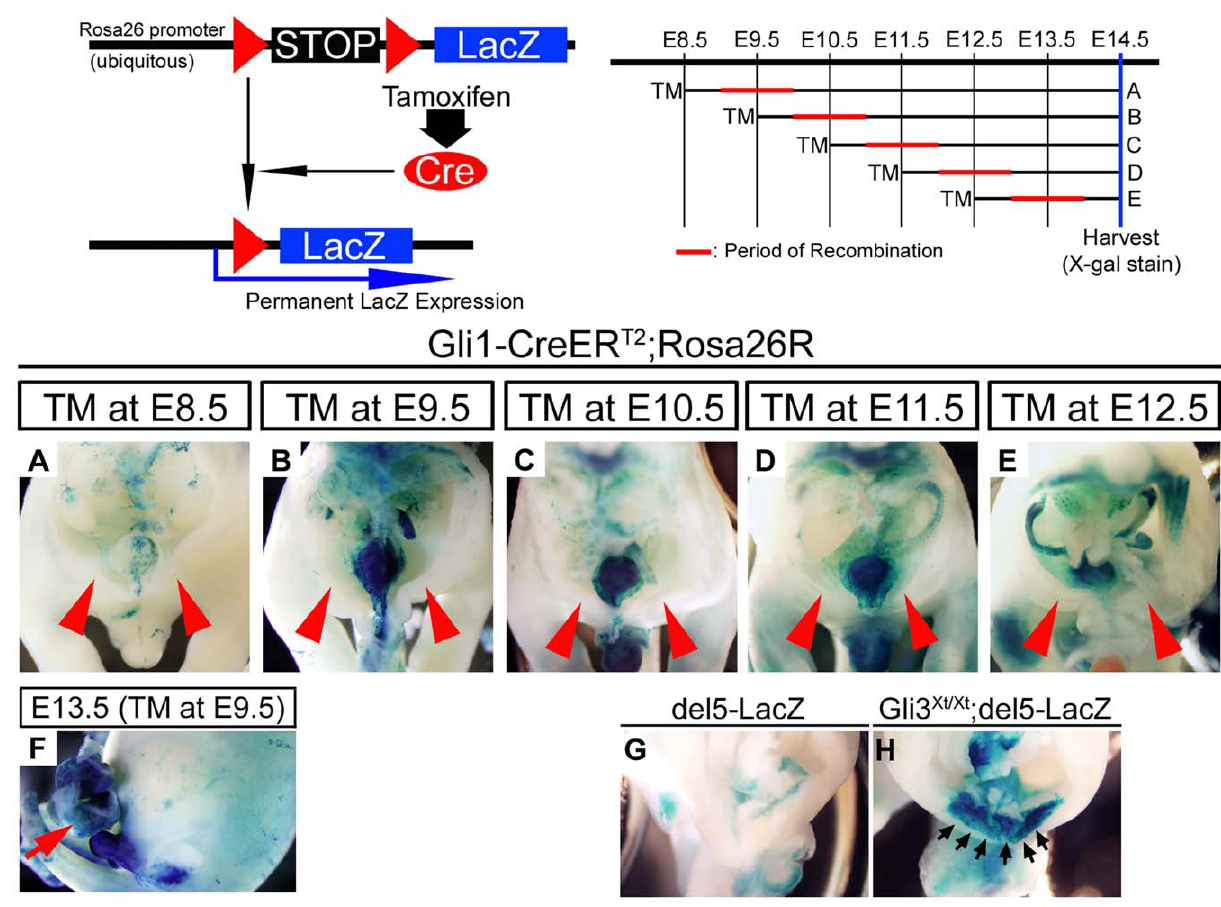
Figure 4. The analysis of Hh-responded cells in the ventral body wall region. A schematic diagram of Hh-responsive cell contribution assays. The R26R allele contains the LacZ gene and a floxed stop cassette under the Rosa26 promoter. The Gli1-CreER T2 allele contains an insertion of TM-inducible Cre recombinase into the Gli1 gene locus. By crossing the Gli1-CreER T2 ; Rosa26R and ICR mice, gene recombination in Hh-responded cells could be achieved specifically under the control of TM. The embryos were stained with X-gal and dissected horizontally at the umbilical cord level. The stages of TM administration and estimated recombination periods in A–E are depicted. Under these TM treatment conditions, few LacZ- positive cells were observed in the ventral body wall ( A–E ; red arrowheads). The lateral view of the embryo also showed few Hh-responded cells ( F ). Red arrow indicates the LacZ-positive population in visceral organs. The del5-LacZ transgenic mice, the Hh signal indicator strain, displayed relatively high ectopic Hh signal activity in the Gli3 Xt/Xt background compared with the control at E12.5 ( G , H ; black arrows).